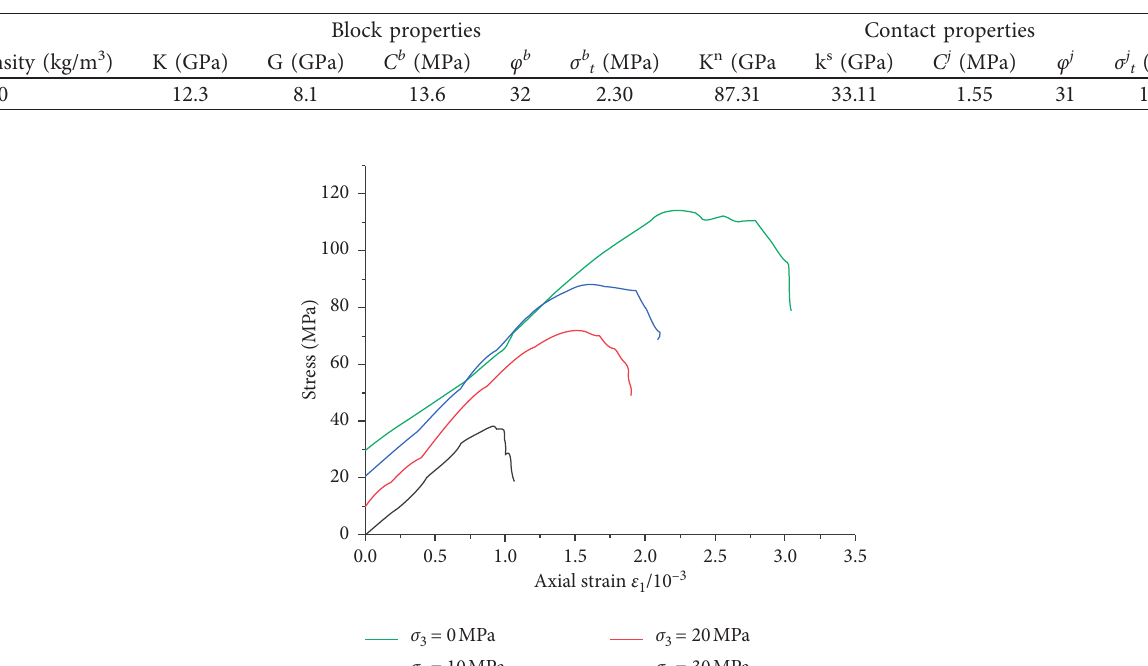
Figure 20: Numerical experiment model. Table 1: Parameters for the rock.